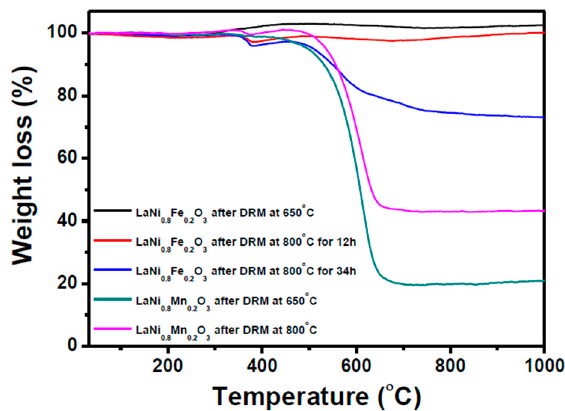
Figure 8. Thermo-gravimetric analyses of LaNi 0.8 Fe 0.2 O 3 and LaNi 0.8 Mn 0.2 O 3 spent catalysts in oxygen atmosphere.